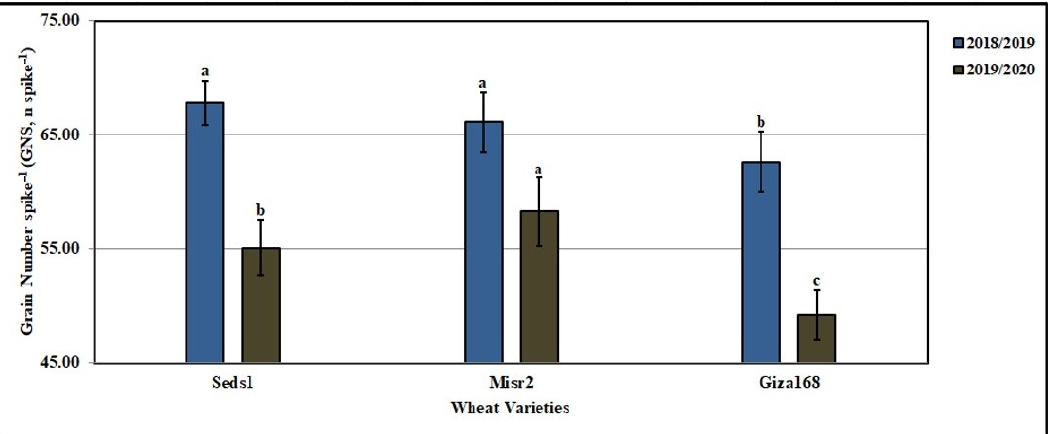
Figure 12. Influence of wheat varieties on grain number spike − 1 (GNS, n spike − 1 ) in clay loam soil in 2018/2019 and 2019/2020 seasons. Bars in the same years with a different letter indicate significant differences between treatments at p ≤ 0.01. HS 1, HS 2 , HS 3 represent HS applied as foliar spray at 1.0, 2.0, 4.0 g L − 1 , respectively, HS 4 , HS 5 , HS 6 represent HS applied as soil application at 5.04, 7.56, 10.08 kg ha − 1 .